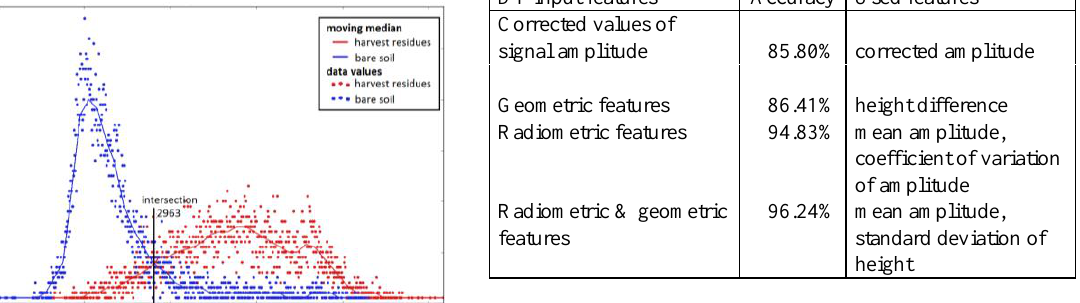
Table 2. Accuracy of DT classification of training data with varying input features and the resulting thresholds. The input features are listed in detail in Table